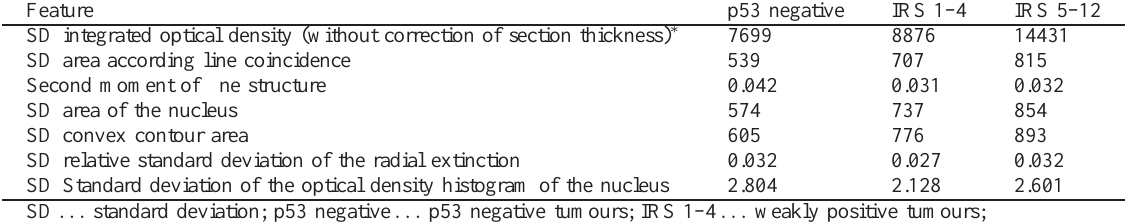
Table 6 Significance in different features of tumours with different p53 expression with a S-phase greater than 5% ( p < 0 . 05)